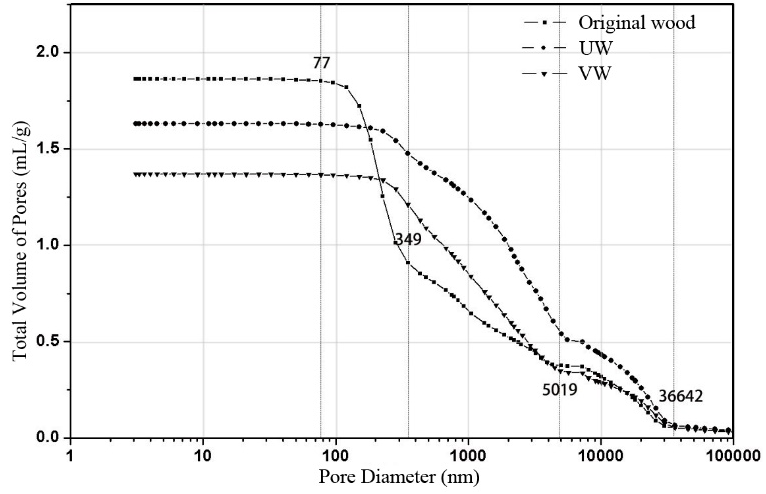
Figure 5. Total volume of pores vs. the pore diameter of original wood, UW, and VW.